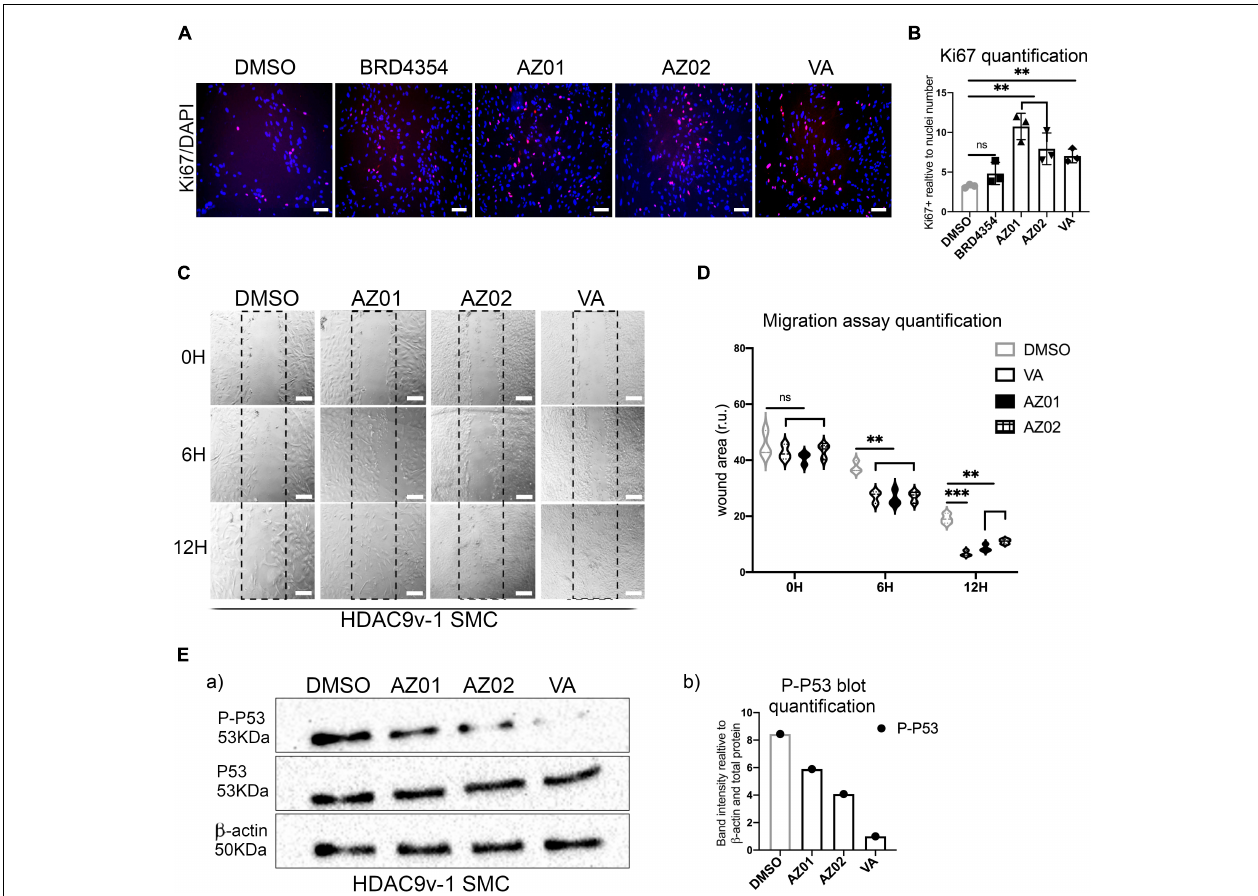
FIGURE 4 | Valproate and AZ class II inhibitors rescue risk SMC proliferation and migration phenotypes. (A) Proliferation rate measured by Ki67 staining in HDAC9-v1 control (DMSO) and treated with BRD4354, AZ01, AZ02 HDAC class II inhibitors and sodium valproate (VA) and (B) quantification of Ki67 staining expressed relative to cells number (nuclei). (C) Representative images of scratch wound assays of iHDAC9 and HDAC9v-1 SMC treated with AZ01, AZ02, and VA at the indicated time points (0, 6, and 12 h) and (D) quantification of the wound areas. (E) Cropped blot of phospho-p53 (P-P53), total P53 and β -actin control for HDAC9v-1 control (DMSO) and upon treatment with AZ01, AZ02 and VA (a) and quantification (b). Nuclei were stained with DAPI. Scale bar = 100 µ m. The results are presented as means ± SD of three independent experiments. ∗∗ P < 0.01; ∗∗∗ P < 0.001; ns, not significant. Statistical analysis was performed by 1-way (B) and 2-way (D) ANOVA with Tukey’s multiple comparison